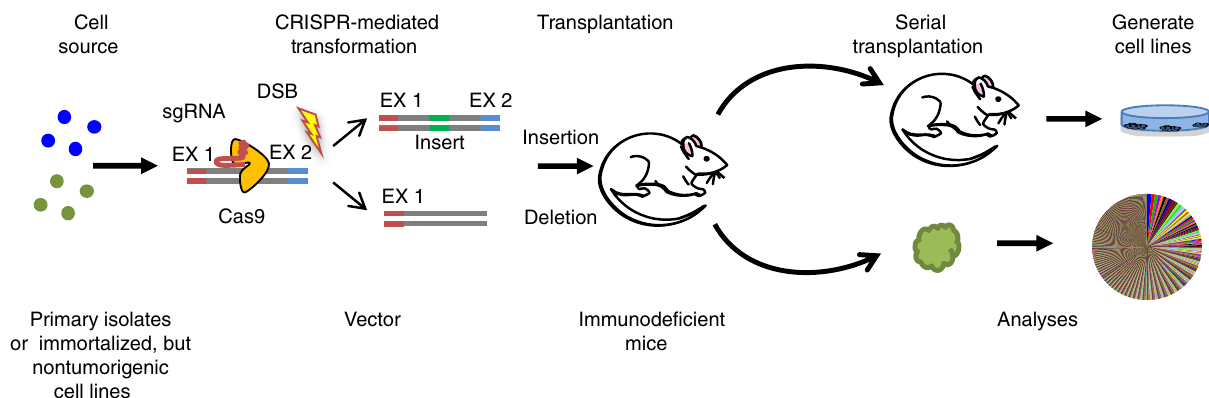
Figure 3 | Use of CRISPR/Cas9 gene editing to examine the tumorigenic consequences of modifying specific genes in human cells. In this methodology, the test cells are exposed to CRISPR/Cas9 reagents and then transplanted into immunodeficient mice as in